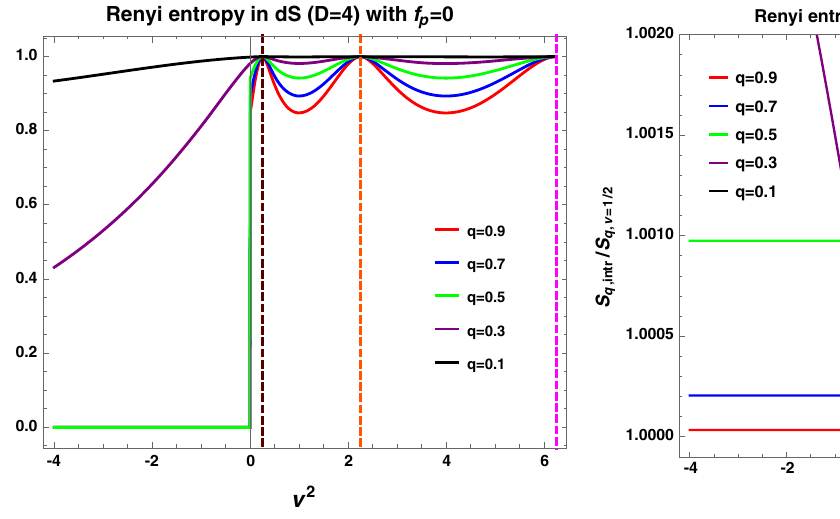
(b) Normalized R´ e nyi entropy vs ν 2 in 3+1 D de Sitter space with axionic source ( f p = 10 − 7 ). ‘ + ’ branch of solution of | γ p | and | (cid:17) p , n | . Here we set (cid:14) C = 10 , 000. In both the cases we have normalised the entanglement entropy with the result obtained from ν = 1 / 2, which is the conformal limit